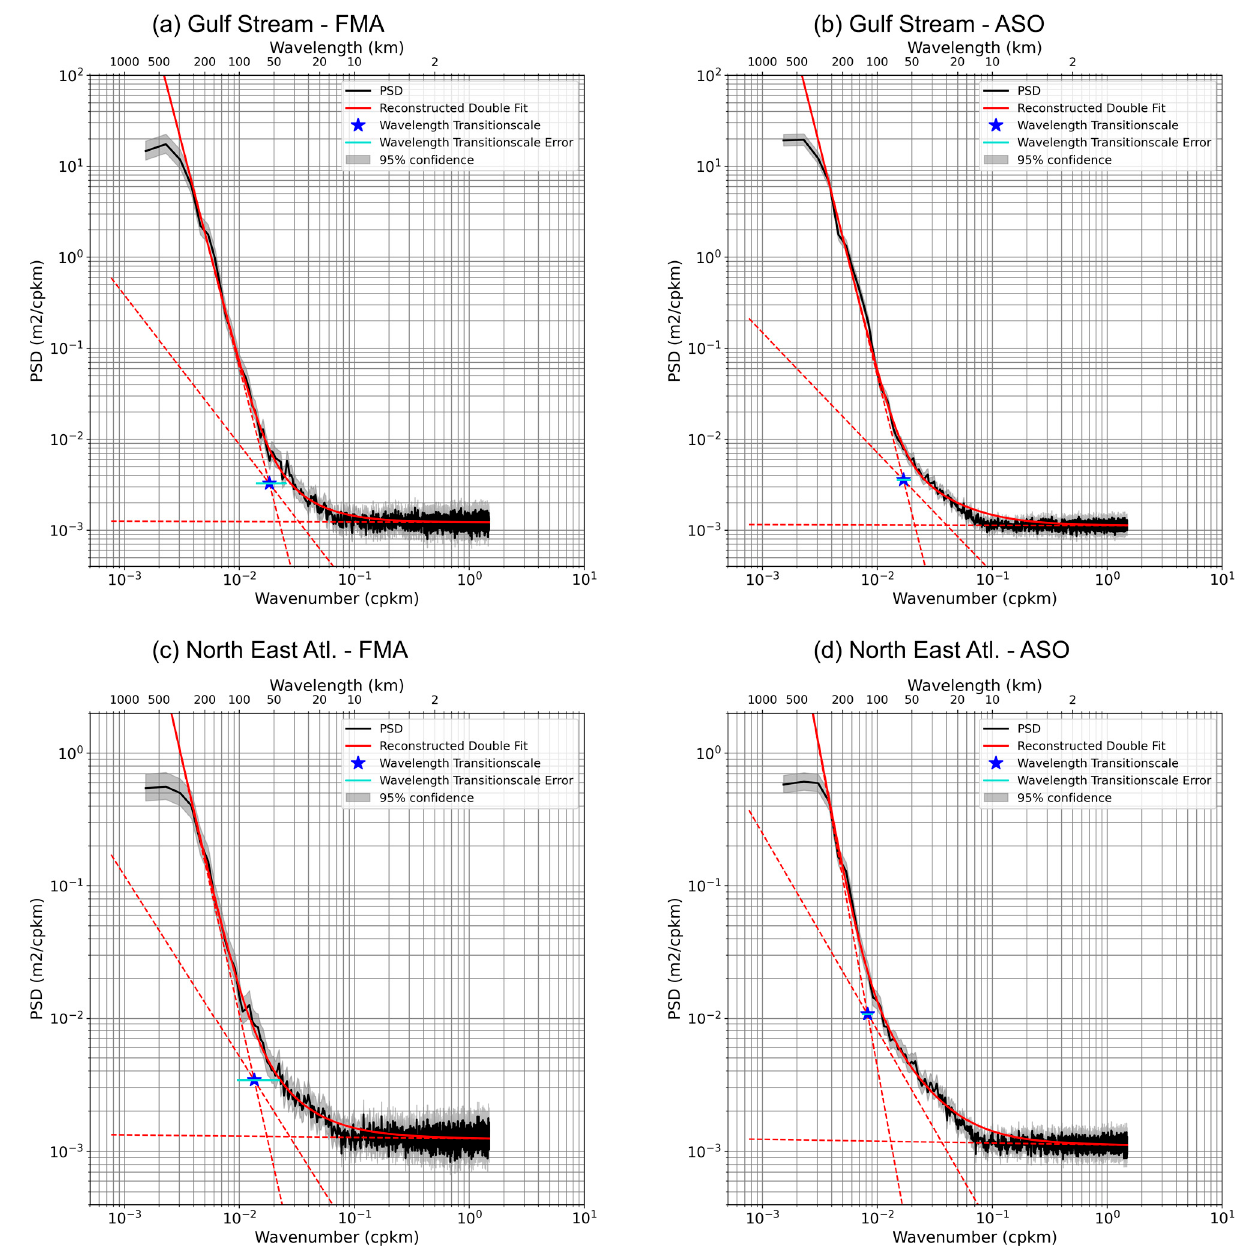
Figure 6. Power spectral density of the SLA along the S3A track in the Gulf Stream domain ( top ) and North Atlantic domain ( bottom ). February–March–April (FMA; left ) and August–September– October (ASO; right ), 2017–2018. The black line shows the true PSD deduced from the signal. The 95% confidence interval is represented by the light gray band centered on the true PSD. The dashed red lines show the 3-slope spectral decomposition. The thick red line shows the theoretical spectrum deduced from the sum of the 3 different slopes. The blue star shows the transition scale (Lt) dividing balanced from unbalanced motions.